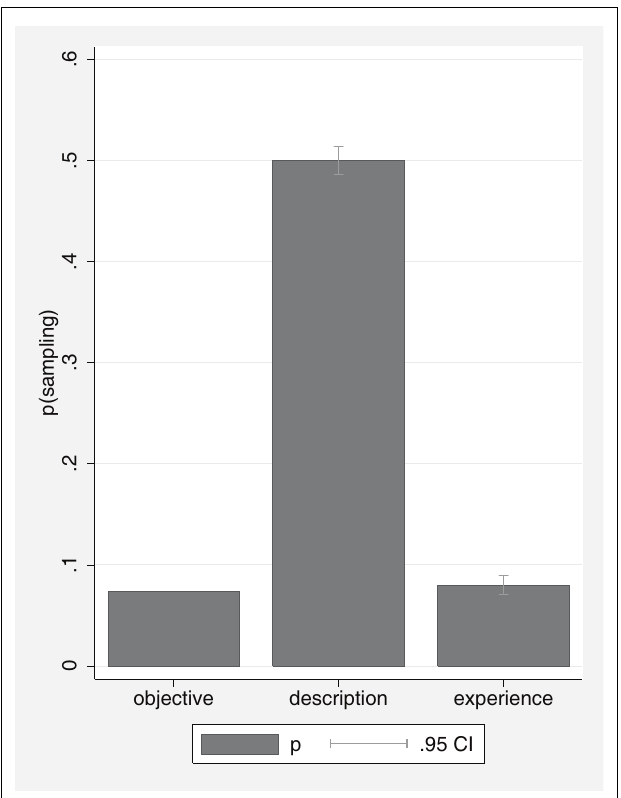
FIGURE 3 | Choices in line with overweighting of small probabilities. Note. Higher scores in p (overweighting) indicate stronger overweighting of rare